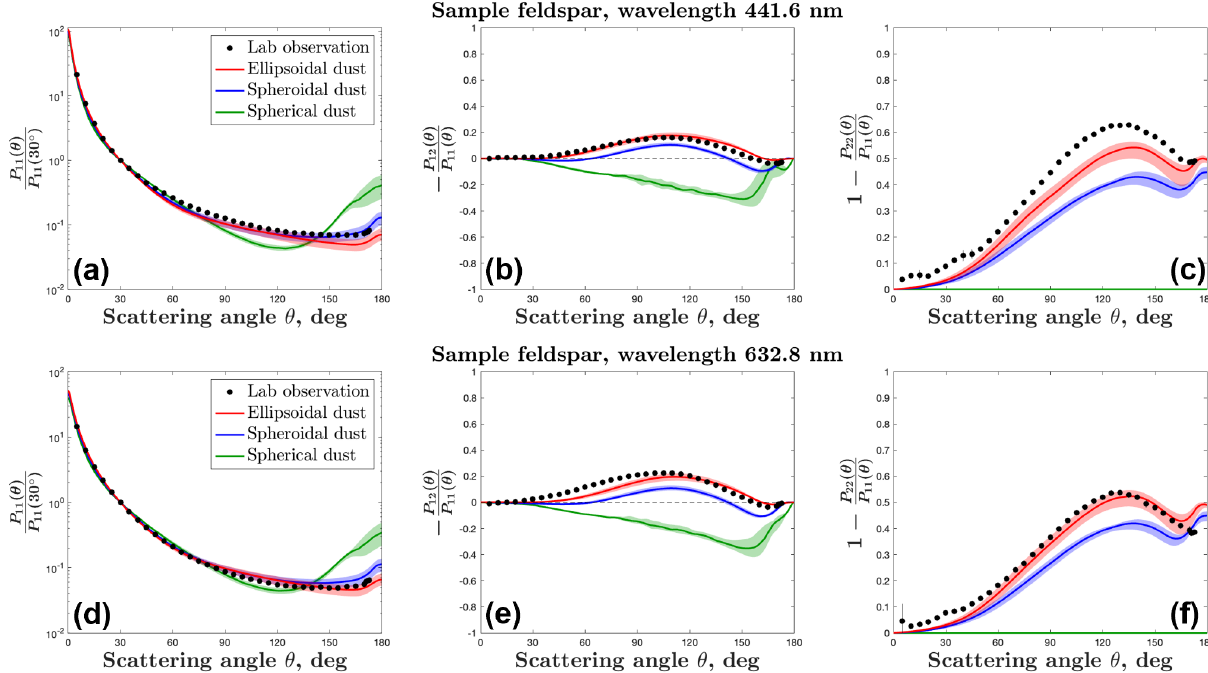
Figure 3. Comparison of the laboratory-measured scattering matrix of AGLSD mineral sample feldspar against the spherical, spheroidal, and ellipsoidal dust optics simulations at the wavelengths of 441.6nm (a–c) and 632.8nm (d–f) . For the three simulations, the central lines denote the medians, and the shaded ranges represent the 95% confidence intervals; these uncertainties are due to uncertainties in the dust refractive index and dust shape distributions (see Sect. 2.2 and 2.3).